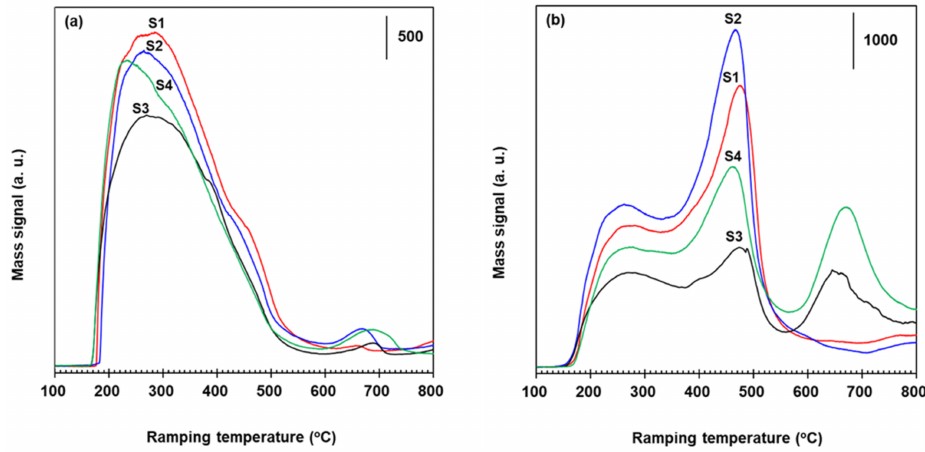
Figure 5. Mass spectra for NH 3 desorbed and H 2 O produced during NH 3 TPD runs with unpromoted and Fe 2 O 3 -promoted catalysts: ( a ) NH 3 and ( b ) H 2 O. In ( a ) and ( b ), S1: VWT; S2: 2.73% Fe 2 O 3 /VWT; S3: c-VWT; S4: 2.73% Fe 2 O 3